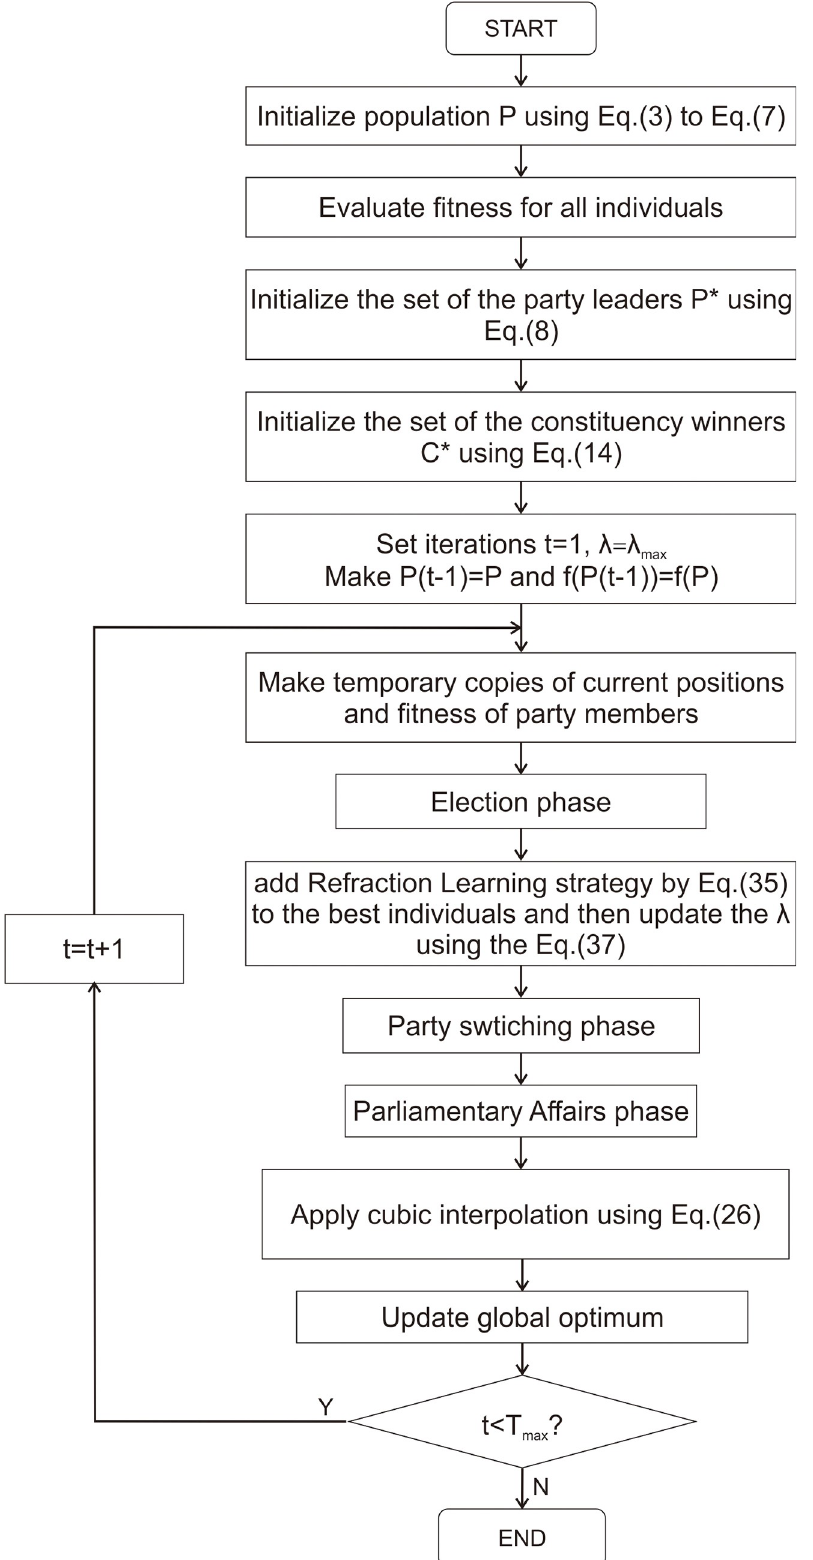
Fig 7. The flow chart of